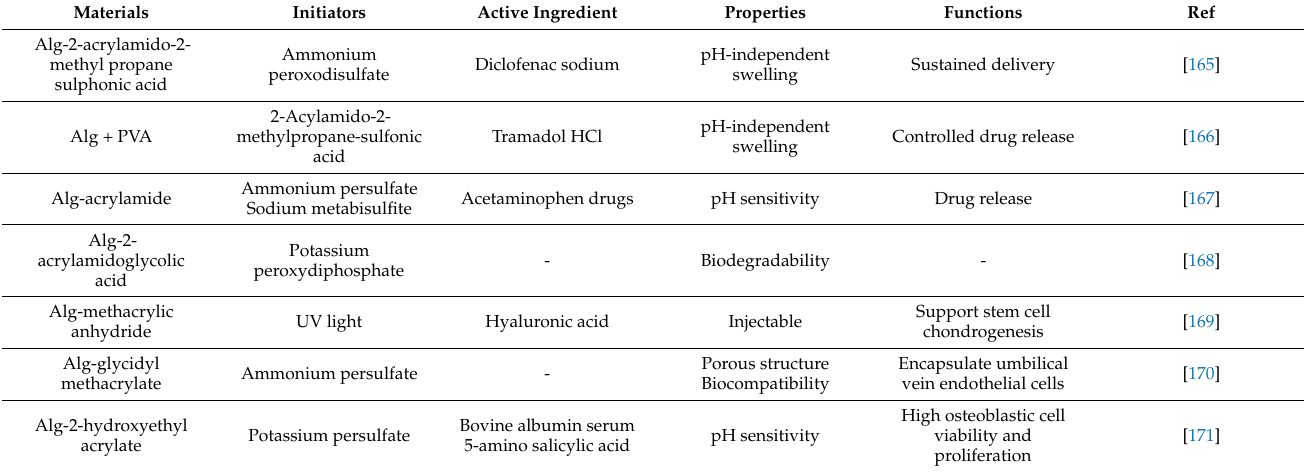
Table 3. The properties, and functions of Alg-based hydrogels prepared by free radical